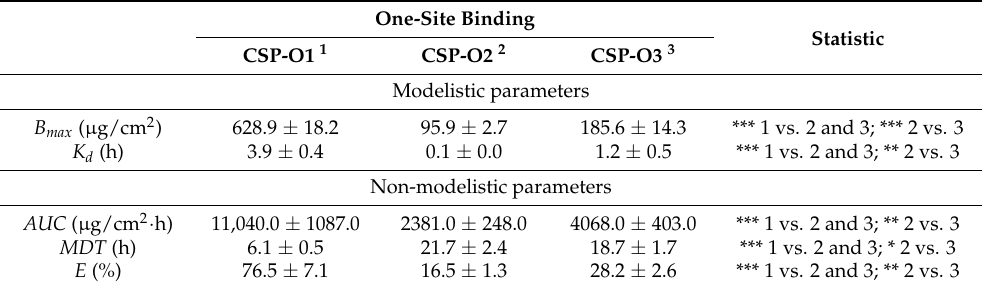
Table 3. Modelistic parameters obtained after fitting the data to the best release model (one-site binding model) of the formulations and non-modelistic parameters. Values represent the mean ± SD ( n = 5).